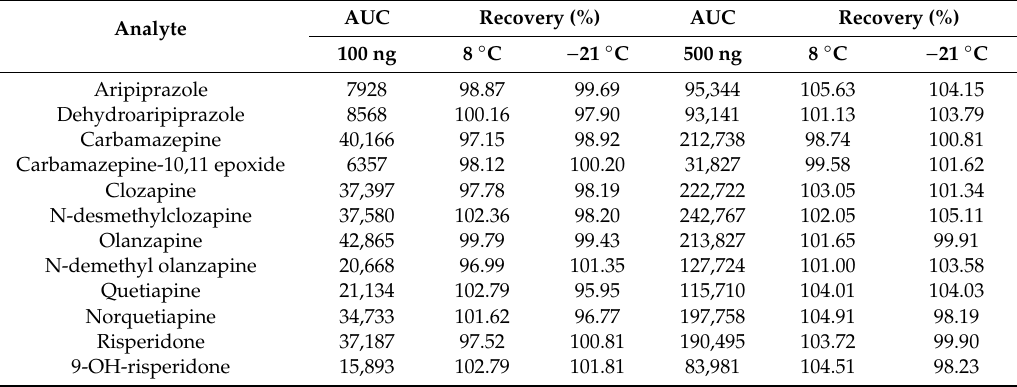
Table 5. Adhesion of analytes on the plastic tube walls stored in fridge at 8 ◦ C and after freeze at − 21 ◦ C. Values in table reflect the percentage of analyte AUC in relation to the AUC determined before the